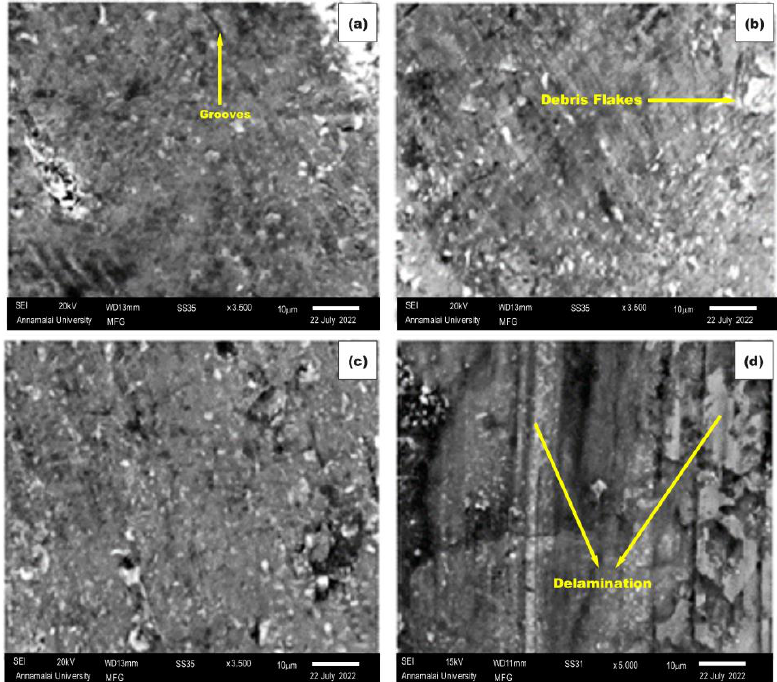
Figure 16. Micrographs showing worn-out surfaces of TiB 2 -15Si 3 N 4 -3B 4 N at: ( a ) 6 N, ( b ) 12 N, ( c ) 18 N, and ( d ) 24 N.